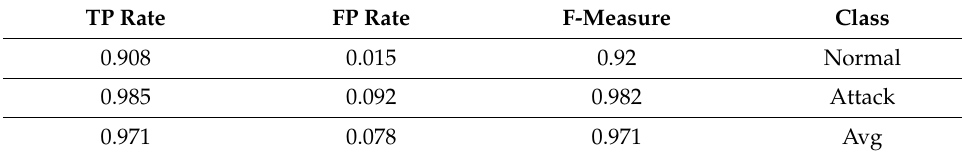
Table 12. Detailed accuracy of